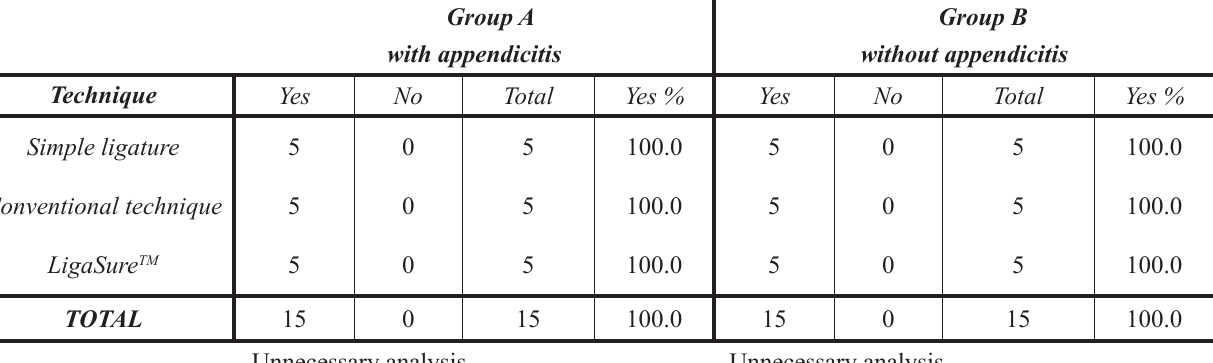
TABLE 2 - Rabbits from groups A and B in the three operative techniques for the adhesion between loops of small intestine.